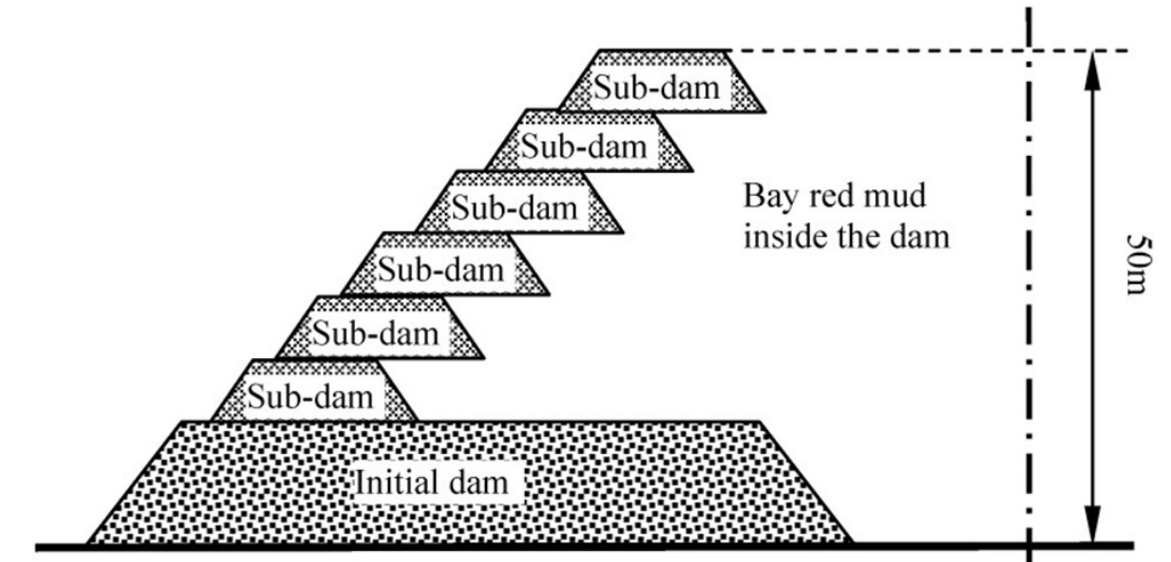
Figure 6. Schematic of the “mixed stocking” method [59].